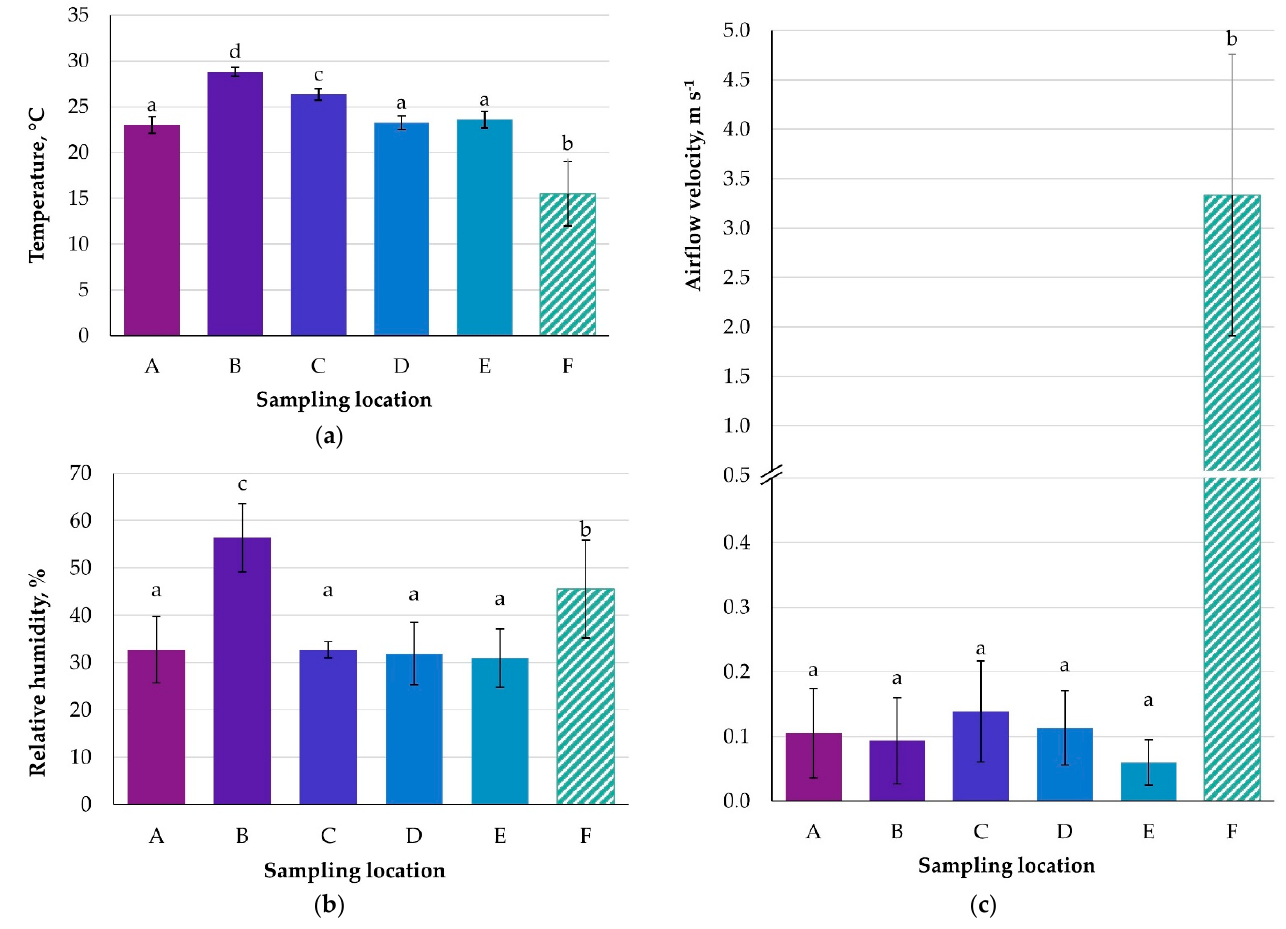
Figure 2. Bar chart showing averaged microclimate conditions at the selected locations; ( a ) temperature, ( b ) relative humidity, ( c ) airflow velocity; means marked with different lowercase letters (a − d) within the particular parameter are significantly different; ANOVA, p < 0.05; Tukey’s HSD test, p < 0.05. (A) “climbing wall”; (B) “swimming pool”; (C) “changing room at the swimming pool”; (D) “basketball/volleyball court”; (E) “badminton court”; (F) “entrance to the building”.